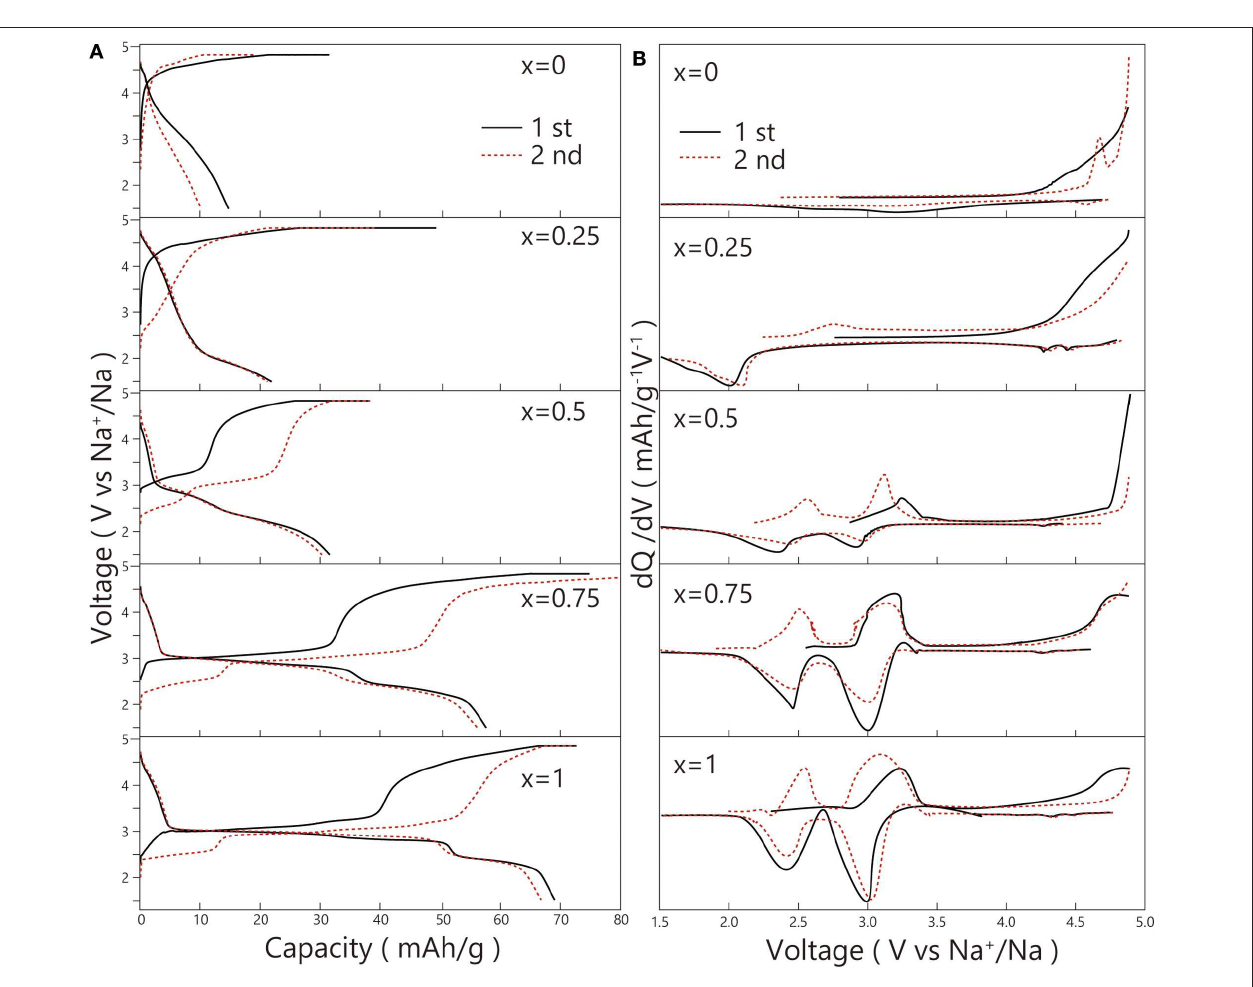
Electrochemical